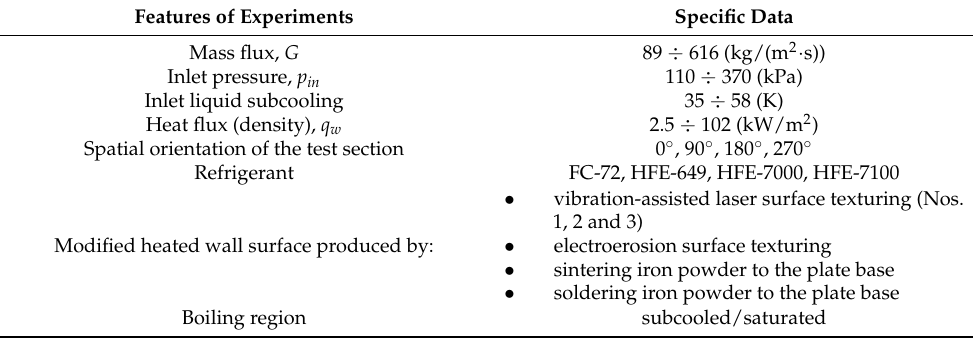
Table 2. Main features of the experiments.